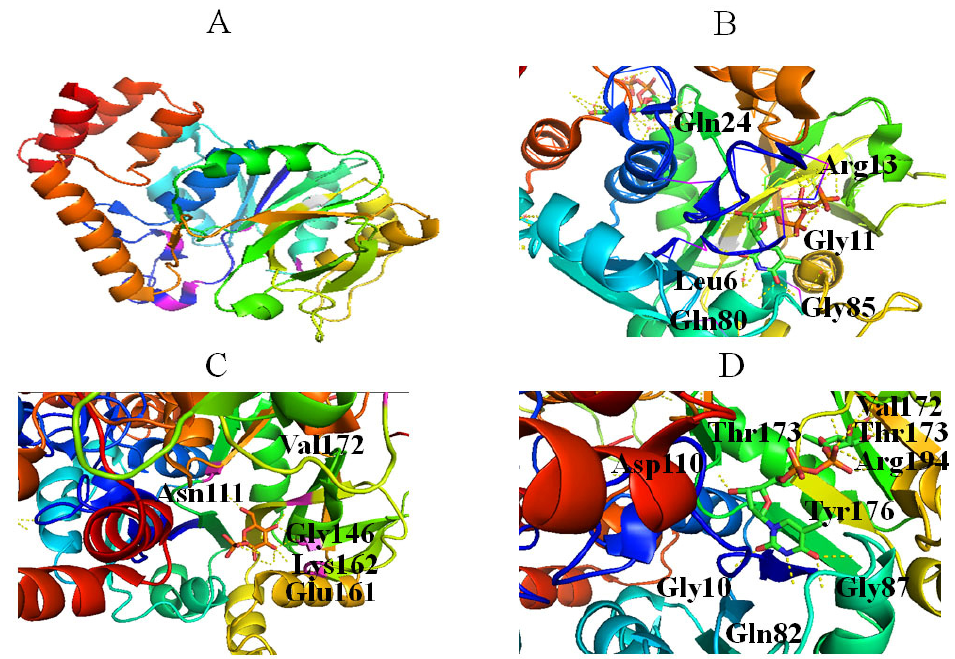
Figure 3. Stereo views of RmlA (Protein Data Bank (PDB) entry 4HO3) ( A ), dTTP (PDB entry 4HO3) ( B ), Glc-1-P (PDB entry 1G23) ( C ), and dTDP-Rha (PDB entry 1G3L) ( D ) bound to RmlA. Hydrogen bonds are shown as red lines. Helices, sheets, and loops of RmlA are colored blue, purple, and beige, respectively. C, N, O, and P elements of ligands are shown in green, blue, red, and brown, respectively. RmlA is shown in cartoon representation, and ligands are shown as sticks [22].